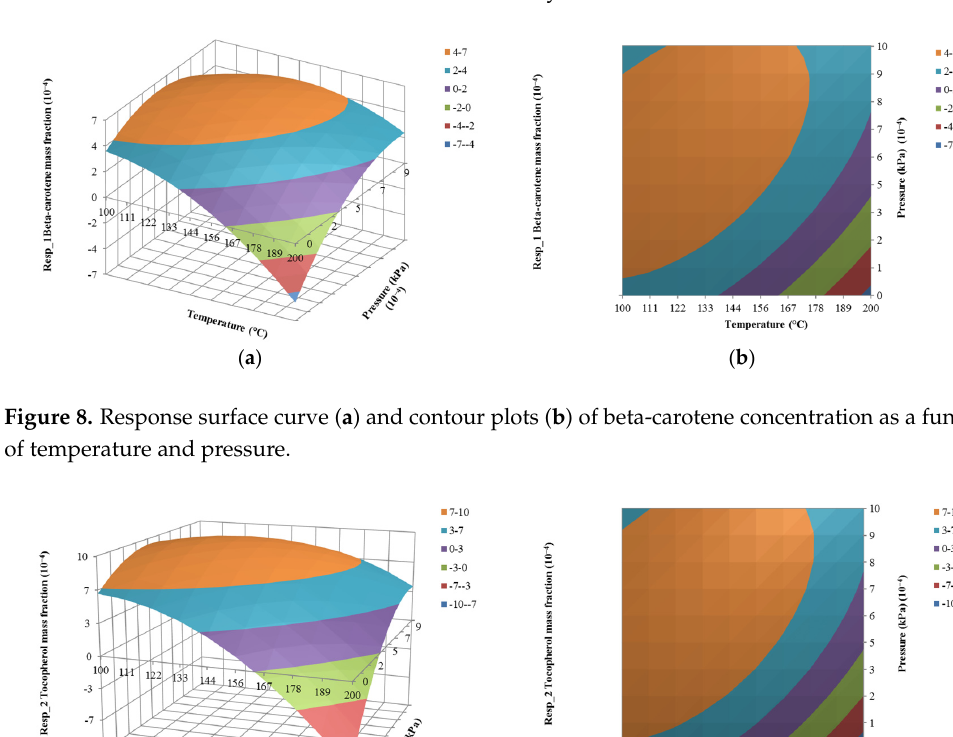
( b ) Figure 6. Response surface curve ( a ) and contour plot ( b ) of tocopherol concentration as a function of temperature and feed flow. ( a ) ( b ) Figure 7. Response surface curve ( a ) and contour plot ( b ) of FFA concentration as a function of temperature and feed flow. 4.2. The Effect of Temperature on Responses Concentration of beta ‐ carotene, tocopherol and FFA as a function of temperature are investigated at constant feed flow rate and pressure at 1500 kg/h and 5.05 × 10 − 4 kPa respectively (run no. 4 and 5). In Figures 8–10, the temperature shows significant deviation in the responses of